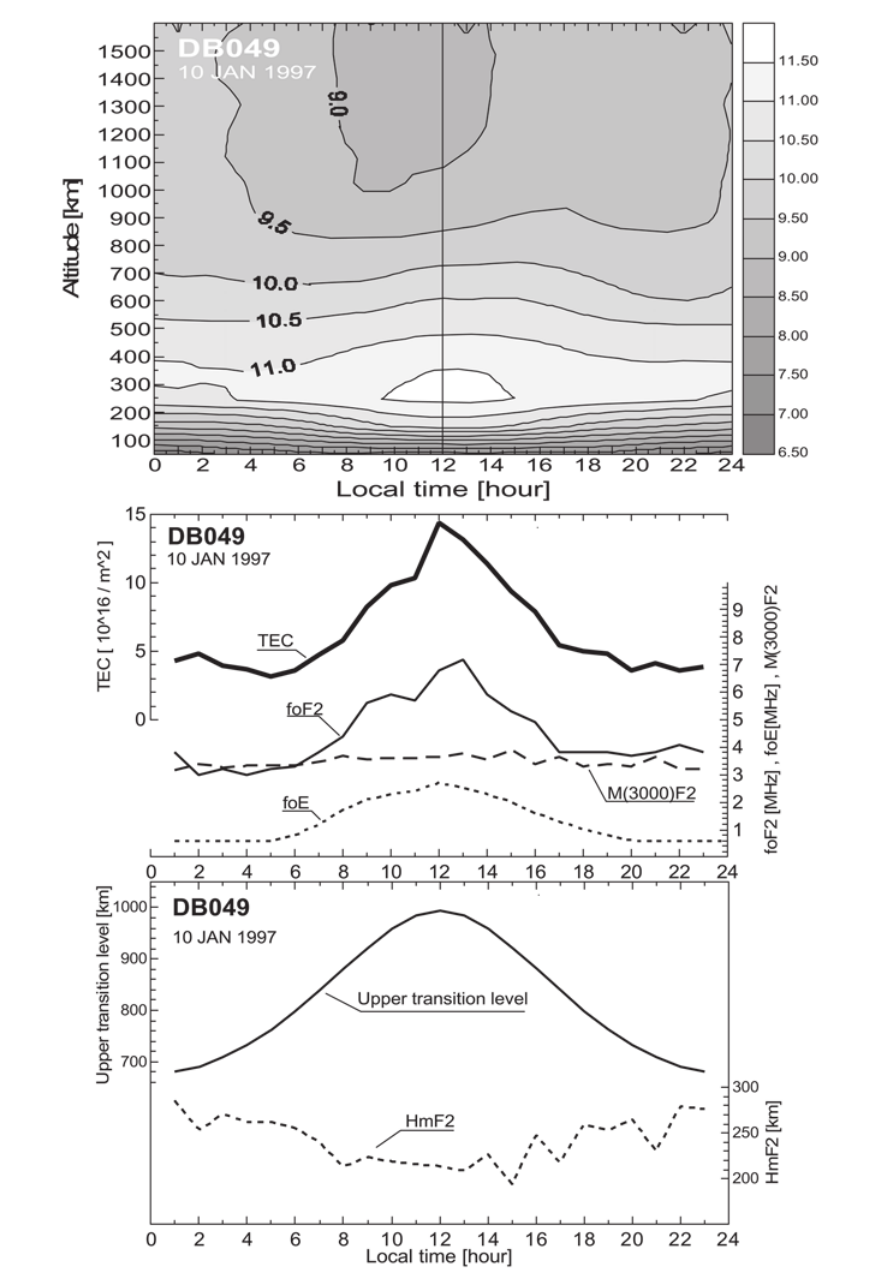
Fig. 7. Diurnal behaviour reconstruction: reconstructed vertical electron density (log scale, m – 3 ) (top), actual GPS TEC and ionosonde measurements (middle), and model-based UTL and H